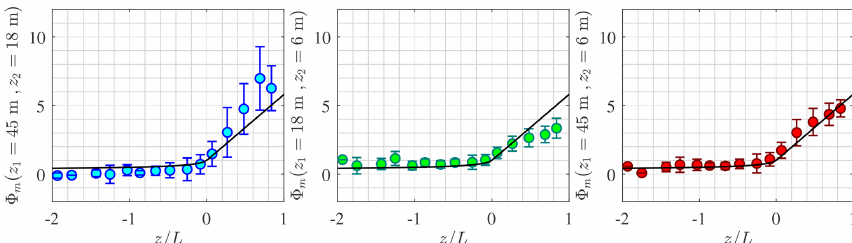
Figure 5. Variation in φ m with the non-dimensional stability parameter ζ estimated from SA at 18ma.m.s.l. The solid black line is Eq. (4), and the error bar represents the interquartile range.